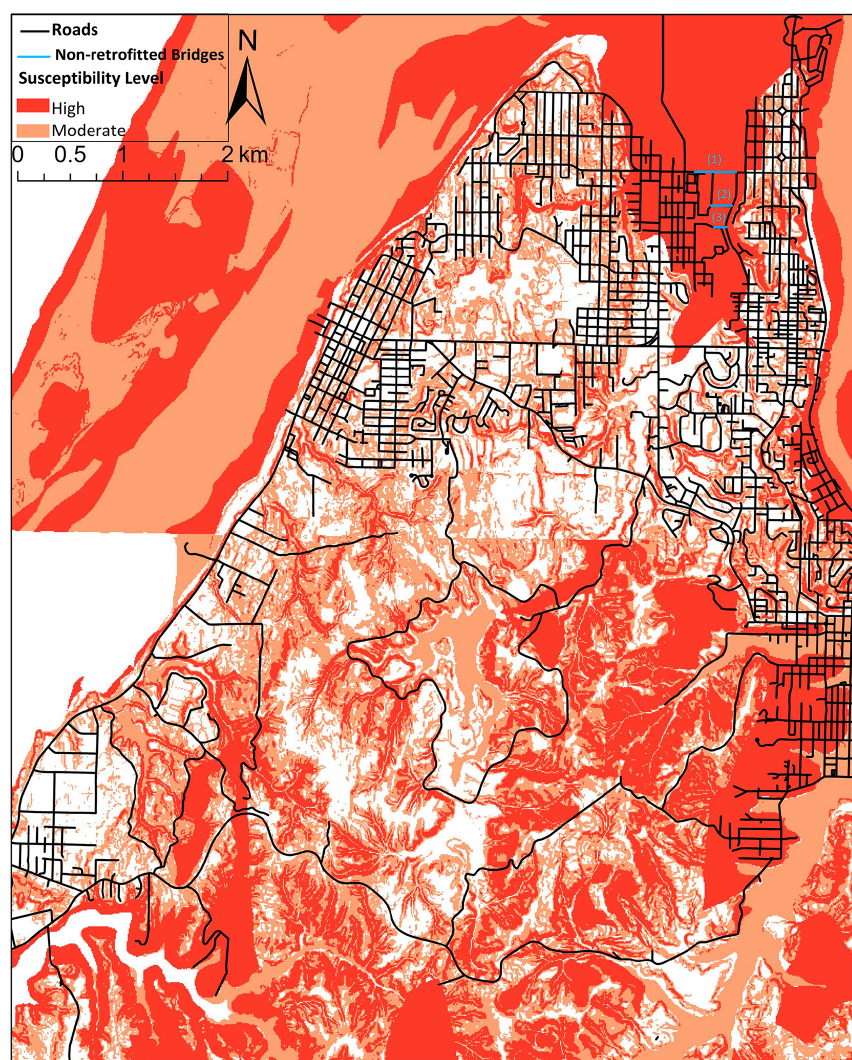
Figure 4. Coos Bay landslide and liquefaction